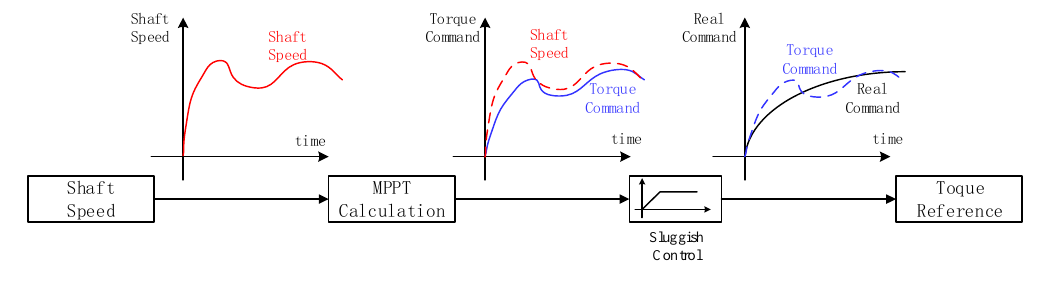
Figure 8. MPPT control strategy.